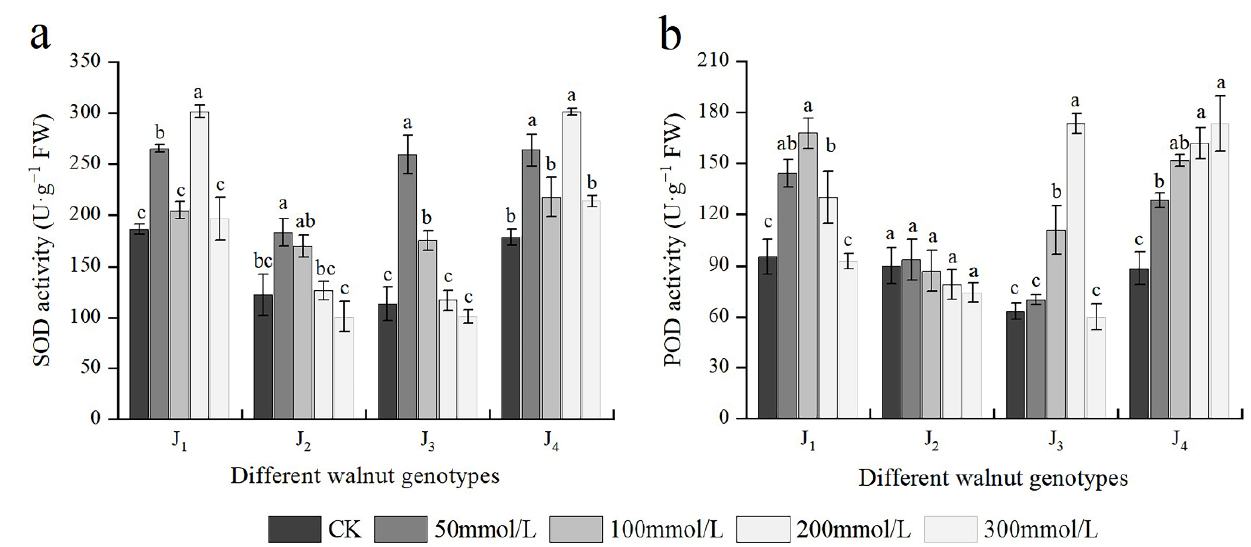
Figure 7. Effect of salt stress on the activities of antioxidant enzymes of walnut. ( a ) Superoxide dismutase (SOD) activity, and ( b ) peroxidase (POD) activity of the leaves. Four walnut genotypes were grown under different NaCl concentrations (0, 50, 100, 200, and 300 mmol/L) for 28 days. Each value indicates the mean ± standard error (SE) of three biological replicates. Bars of each parameter labeled with different letters are significantly different ( p < 0.05) by Duncan’s